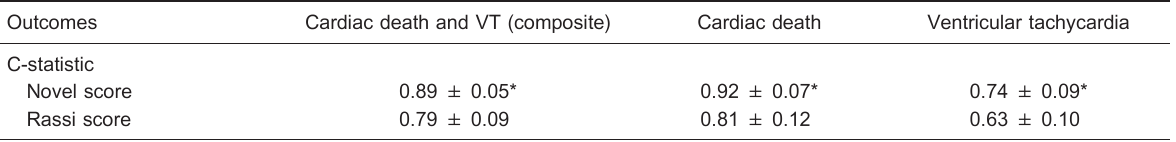
Table 5. Receiver operating characteristic curve bootstrap procedure of the novel score compared to the Rassi score as predictors of composite, cardiac death and ventricular tachycardia (VT) outcomes in the validation group